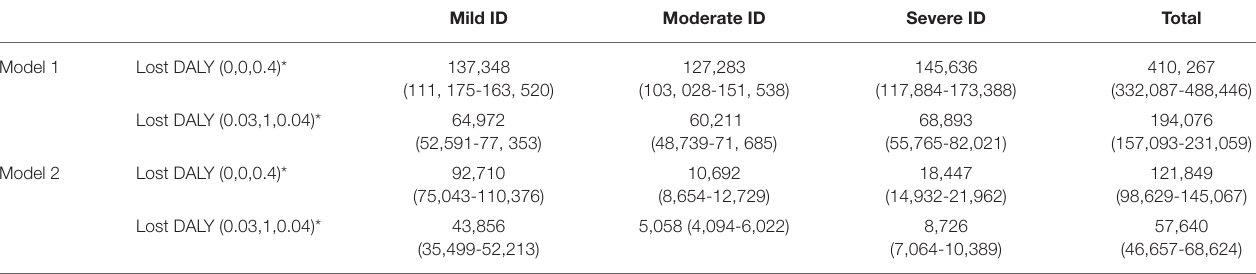
TABLE 4 | Lost disability adjusted life years (DALYs) from CH related intellectual disability.